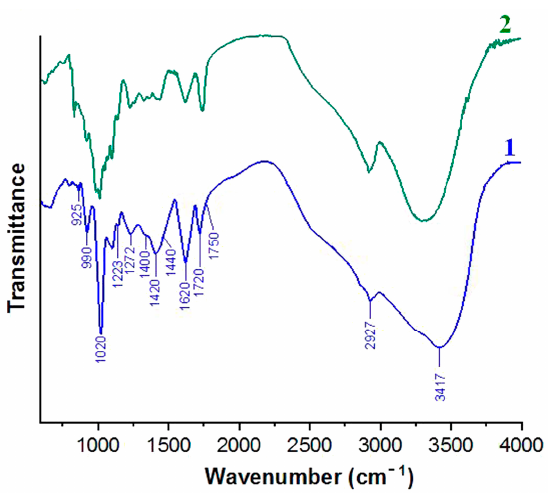
Figure 4. FTIR spectra of P Rh (1) and P Ct (2) pectins.